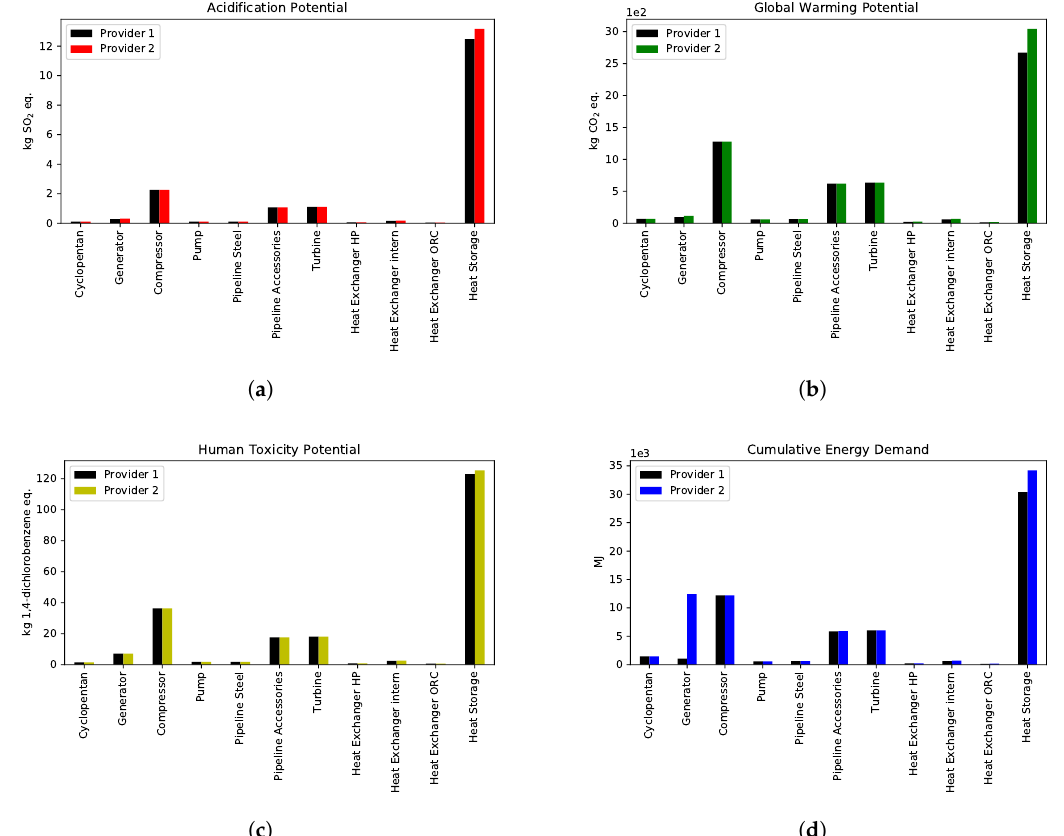
Figure 7. Sensitivity Analysis of different steel providers per MWh storage capacity for: ( a ) AP; ( b ) GWP; ( c ) HTP and ( d )